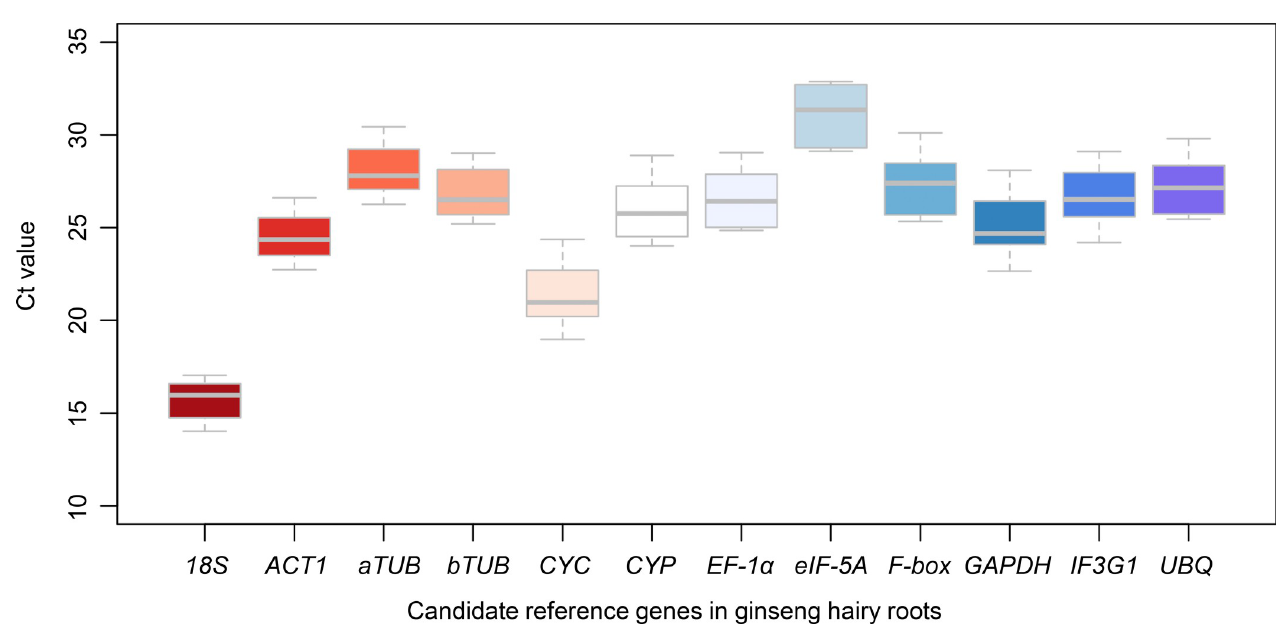
Fig 2. The abundance of candidate reference genes. Ct values of the candidate reference genes indicating their abundances in the